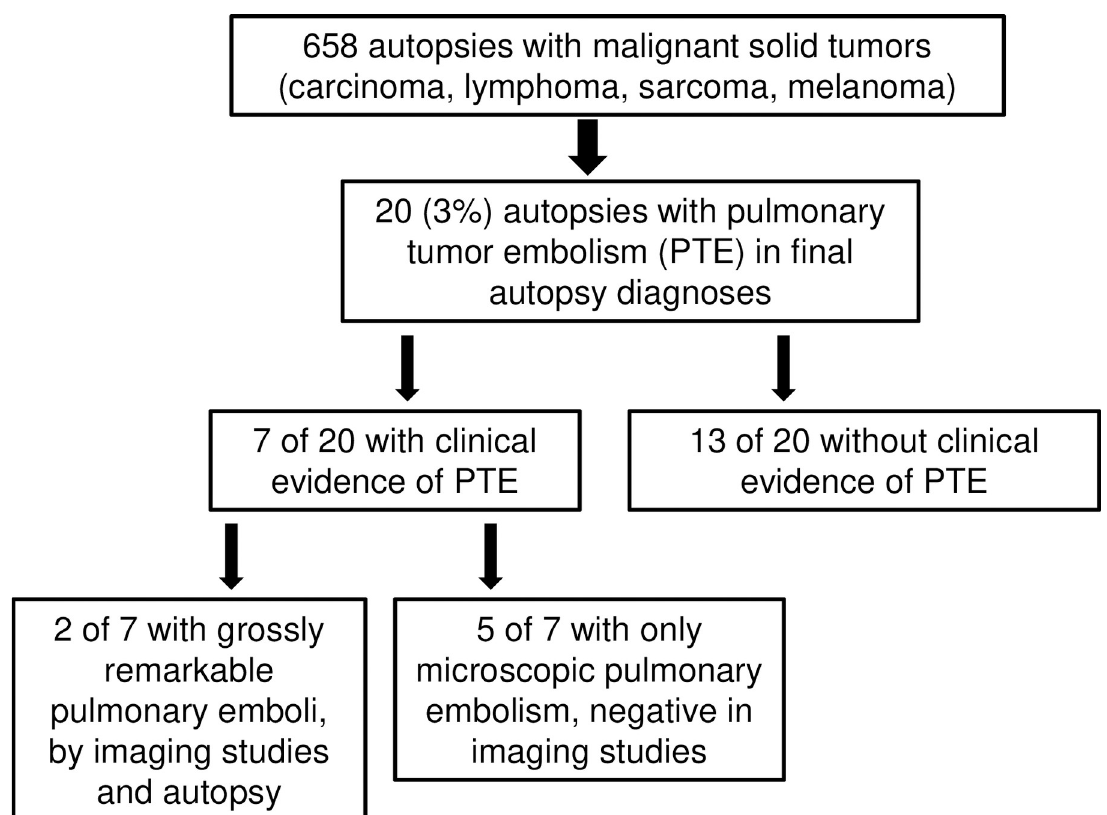
Fig 1. Flowchart of 658 autopsies with malignant solid tumors in our institution.